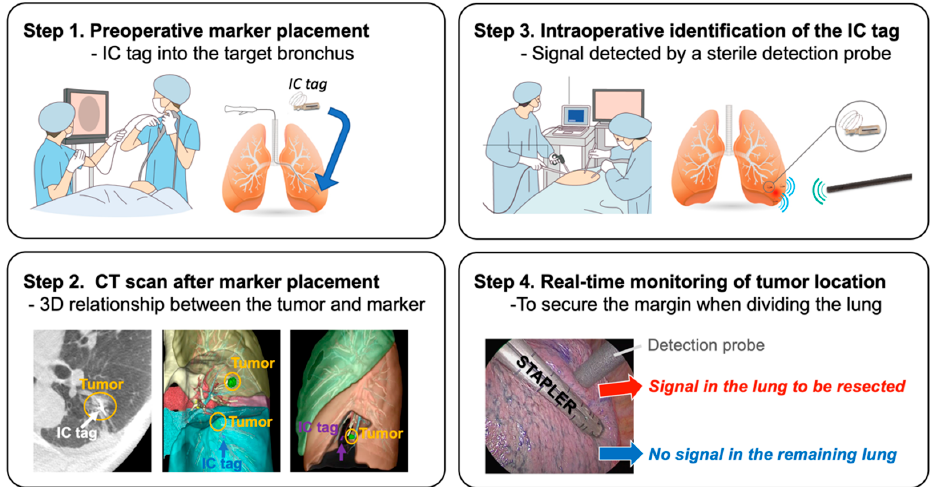
Figure 2. Schema of four steps in radiofrequency identification (RFID) marking. Step (1): Broncho- scopic placement of the RFID marker, IC tag, into the peripheral bronchus within or adjacent to the tumor using a virtual bronchoscopic navigation technique. Step (2): Computed tomography scan